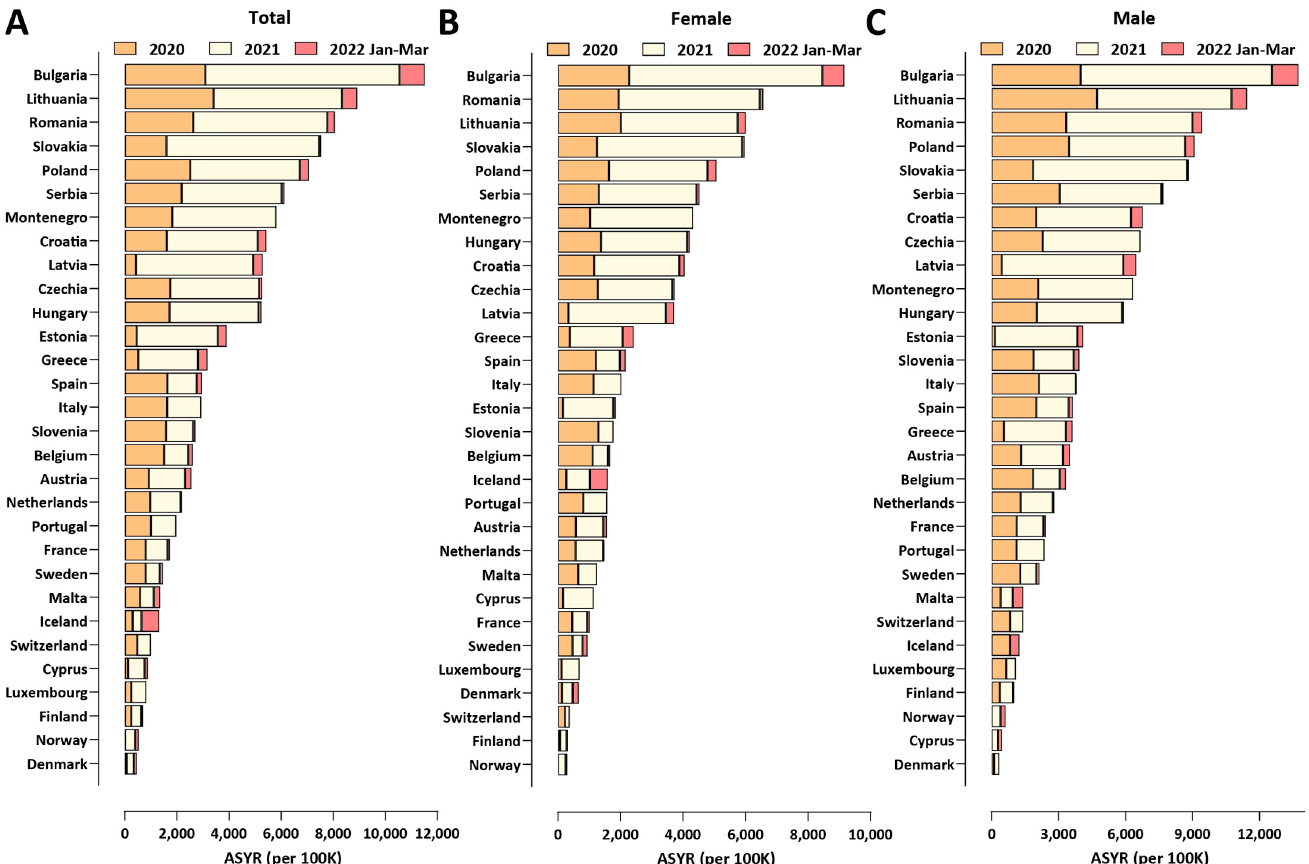
Figure 1. Excess mortality in Europe and Bulgaria during the COVID-19 pandemic (up to the end of March 2022) . ( A ) Standardized ASYR values, total; ( B ) standardized ASYR values, females; ( C ) standardized ASYR values, males.